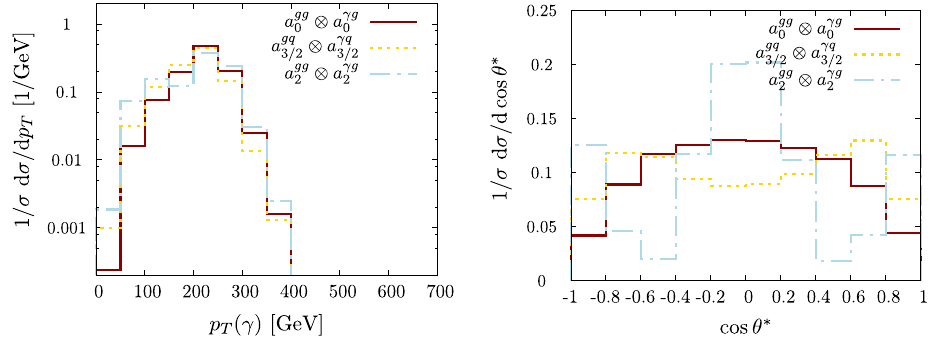
Fig. 3 Normalised transverse momentum and cos θ ∗ distributions for jet+ γ production, focussing on representative spin 3 / 2 and spin 2 couplings of Sect. 2. (Spin 0 included for comparison.) See caption of Fig. 2 for further details. No merging or detector resolution effects are